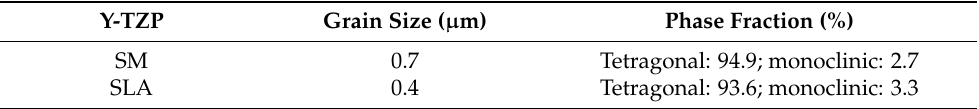
Figure 4. EBSD images of the SM- ( a ) and SLA-fabricated ( b ) Y-TZP ceramics (magnification = 5000 × ; scale bar = 5 µ m). Table 1. Grain size/phase fraction results derived from the EBSD data (Figure